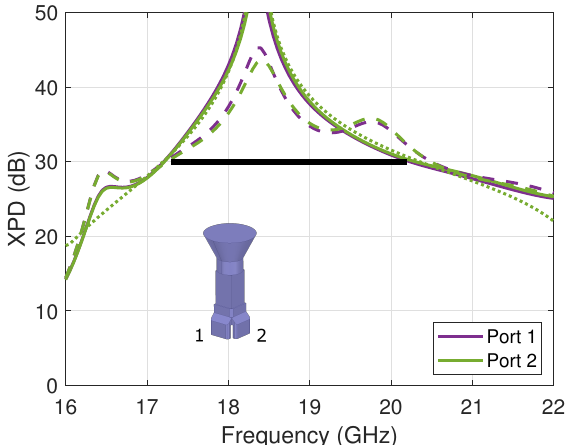
Figure 7. Simulated on-axis XPD of the very compact waveguide OMT with folded single-mode ports assembled with a conical horn ( solid lines ) compared to the reference OMT design with straight single-mode ports ( dashed lines ). The simulated standalone OMT results are overlaid in dotted lines . The specifications are marked with a black thick line